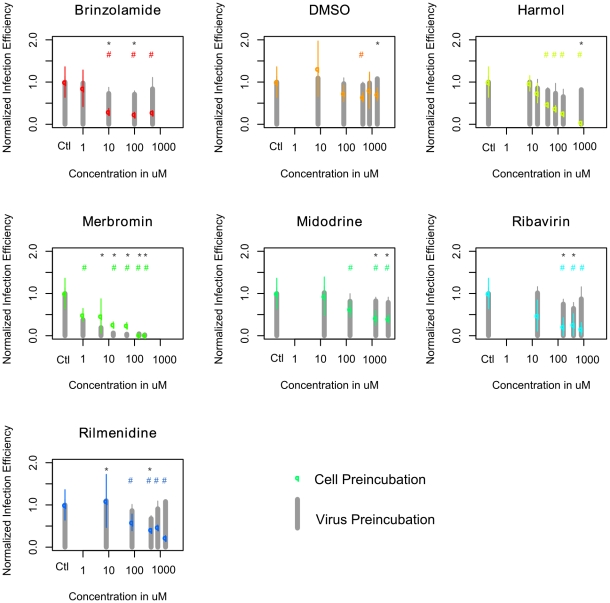
Antiviral effects of most of the molecules are due to an action on cells rather than on the virus.In the ‘Cell Preincubation’ assay, A549 cells were treated with increasing concentrations of the molecules or solvent for 14 h and washed twice before incubation with H3N2 influenza A virus at an moi of 7 during 15 min and infection for 5 h in medium without drug. In the ‘Virus Preincubation’ assay, H3N2 viral stock was treated with increasing concentrations of molecules or solvent for 14 h and diluted 12 times before incubation with cells during 5 min and infection for 5 h. In both assays, the number of infected cells was estimated with a neuraminidase test after cell lysis with Triton 1X. The normalized infection efficiency was calculated as RFU in treated cells/RFU in control cells. Values represent the mean of two independent experiments (+/− standard deviation). Results of the preincubated cell test are plotted with colored dots and results of the virus preincubated assay are depicted with grey bars. * and # indicate statistically significant differences of infection efficiency in comparison to untreated control cells (Welch two-sample t test, pvalue <0.05), for the preincubated cell test and for the preincubated virus test, respectively.